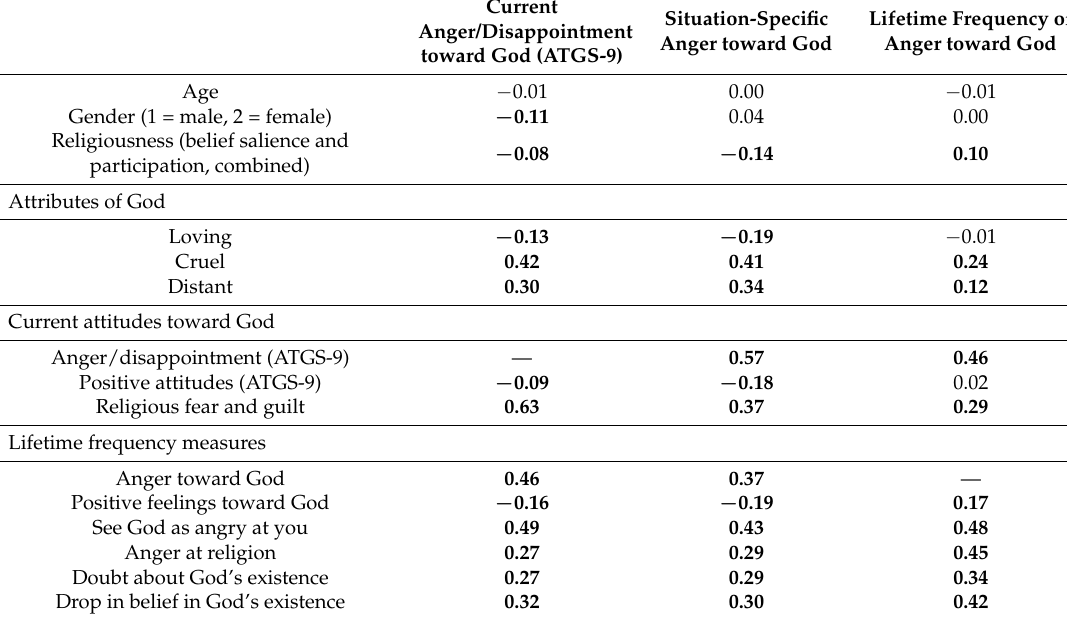
Table 5. Midwestern private university sample: Correlations between key study variables and three measures of anger toward